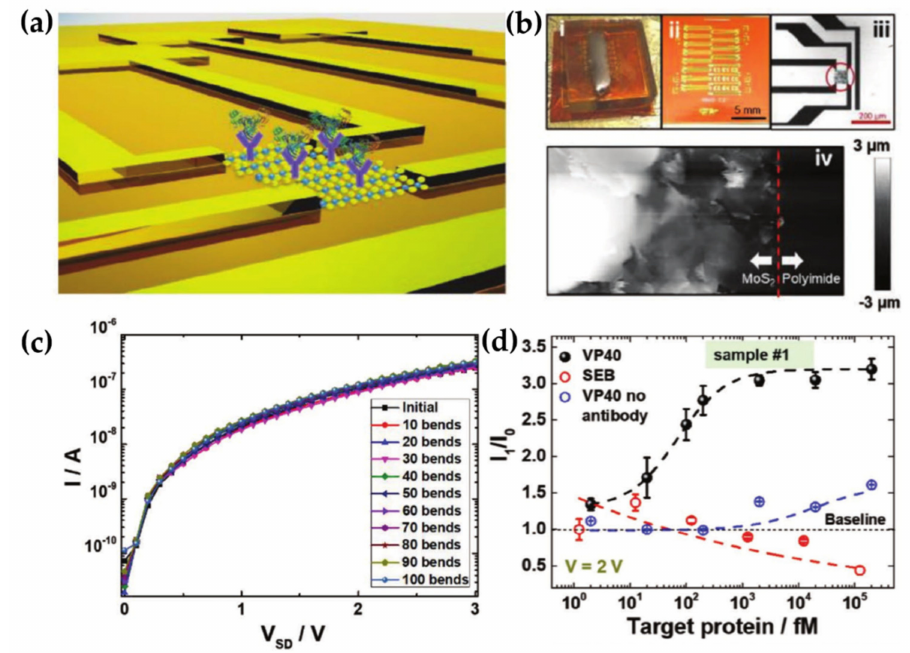
Figure 7. MoS 2 flexible field-effect transistor biosensor for the detection of the Ebola virus. ( a ) Schematic of the biosensor with antibodies anchored to the substrate and antigens recognized by the antibodies. ( b ) Optical images of the device fabrication and atomic force microscopy image of the MoS 2 nanosheet. ( c ) Output characteristic curves (I DS vs. V DS ) for the bending tests, showing no degradation of the I DS current. ( d ) Calibration curves of the device for de detection of the VP 40 with (in black dots) and without (in blue dots) the presence of the VP40 antibodies and in the presence of the interferent staphylococcal enterotoxin B (SEB) (in red dots). Adapted from [150] with